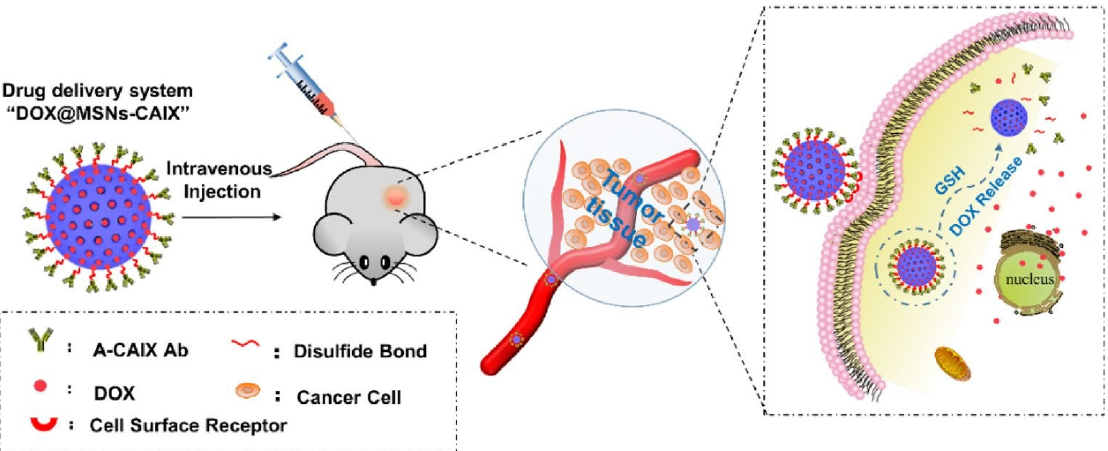
Figure 8. Illustration of A-CAIX Ab targeted mesoporous silica nanoparticles as a redox-responsive drug delivery system (Reprinted with permission from Ref. [71]. 2020, Minmin Chen).